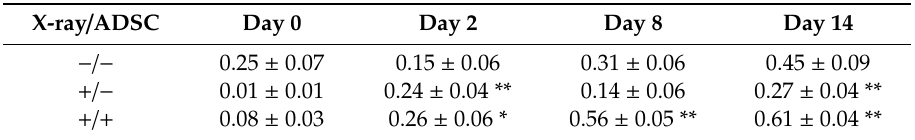
Table 2. Ratio of proliferative lymphatic vessels with LYVE-1 and proliferating cell nuclear antigen (PCNA) immunoreactivity (mean ± SE).